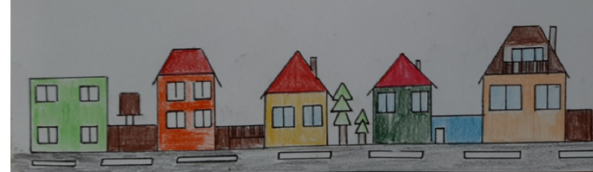
Figure 17. Solution of Task 7 ( top ), and one of the student´s solution ( bottom ).